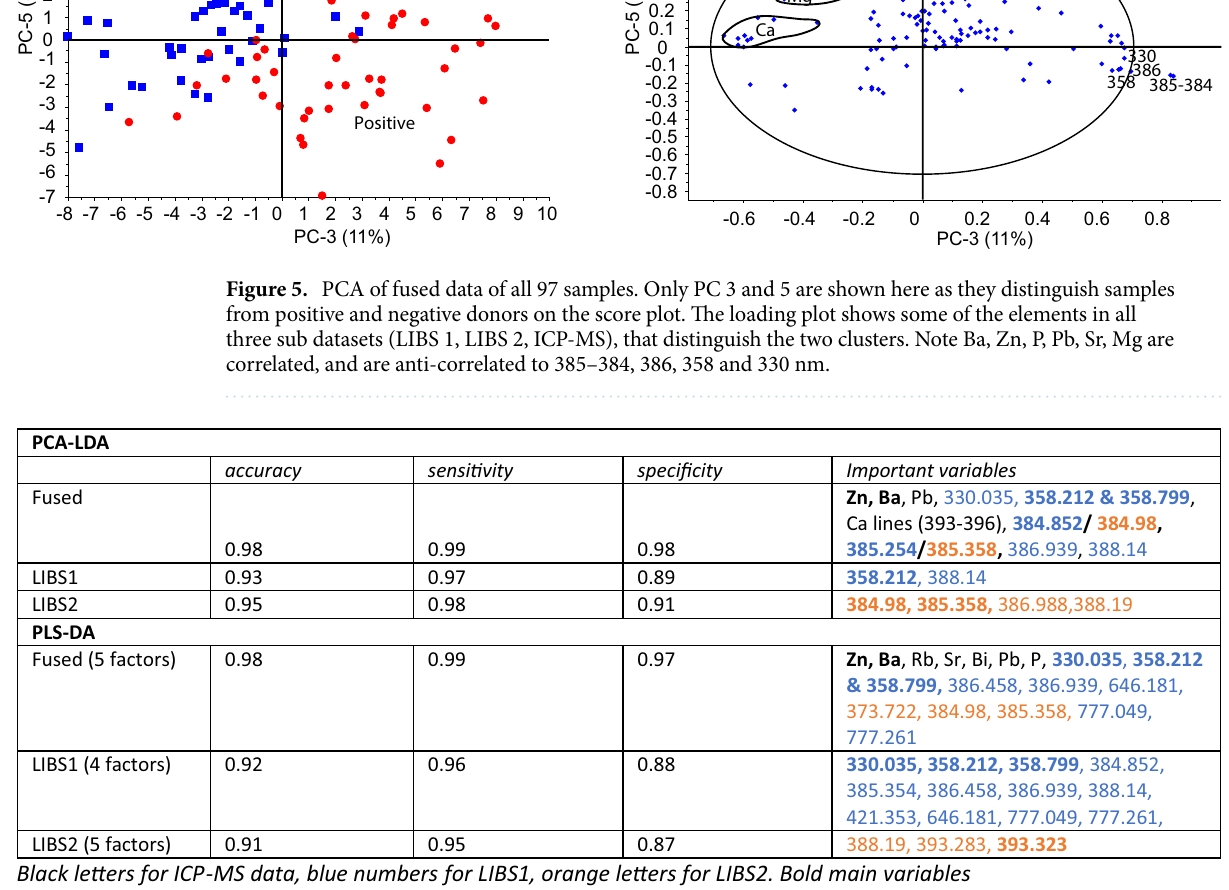
Table1. Results of PCA-LDA and